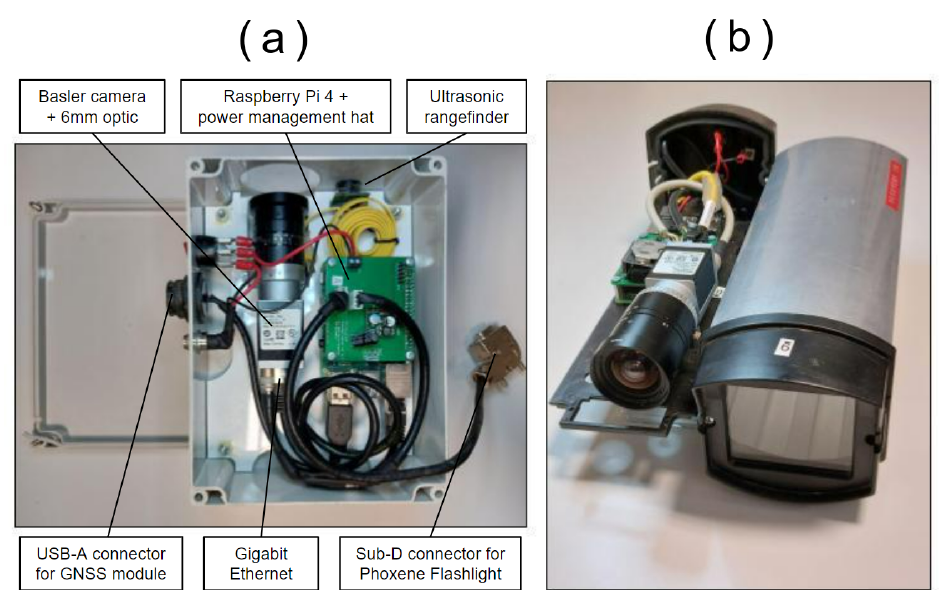
Figure 2. Photography of the sensor embedded in two different cases. ( a ) Large case (including details about devices and connections); ( b ) Narrow case.